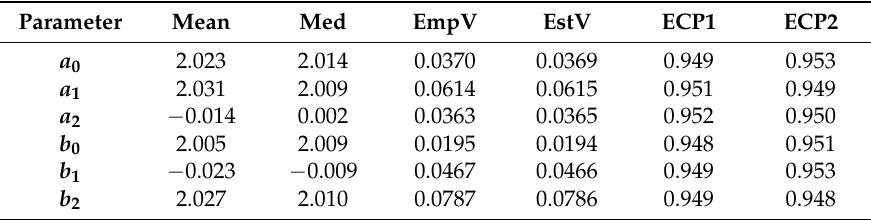
Table 2. Results from Simulation Studies with Bootstrapping ( n =